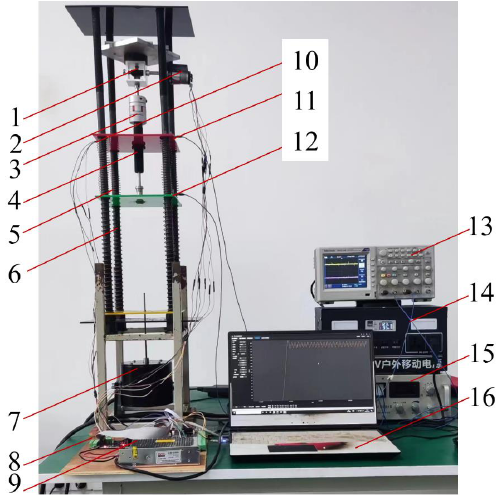
Figure 14. Test diagram of mode switching control on the variable road surface. 1. Gear mechanism 2. DC motor 3. Coupling 4. AD adjustable damper 5/6. Spring 7. Actuator 8. Controller 9. Data pickup card 10. Feedback acceleration sensor 11/12. The acceleration sensor 13. Oscilloscope 14. DC regulated power supply 15. Power Amplifier 16. Upper computer.